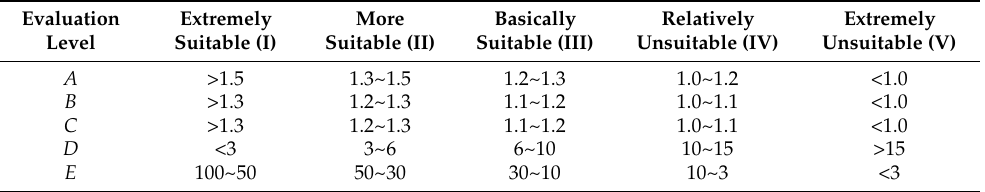
Table 1. Relationship between Indices and Evaluation Level of the